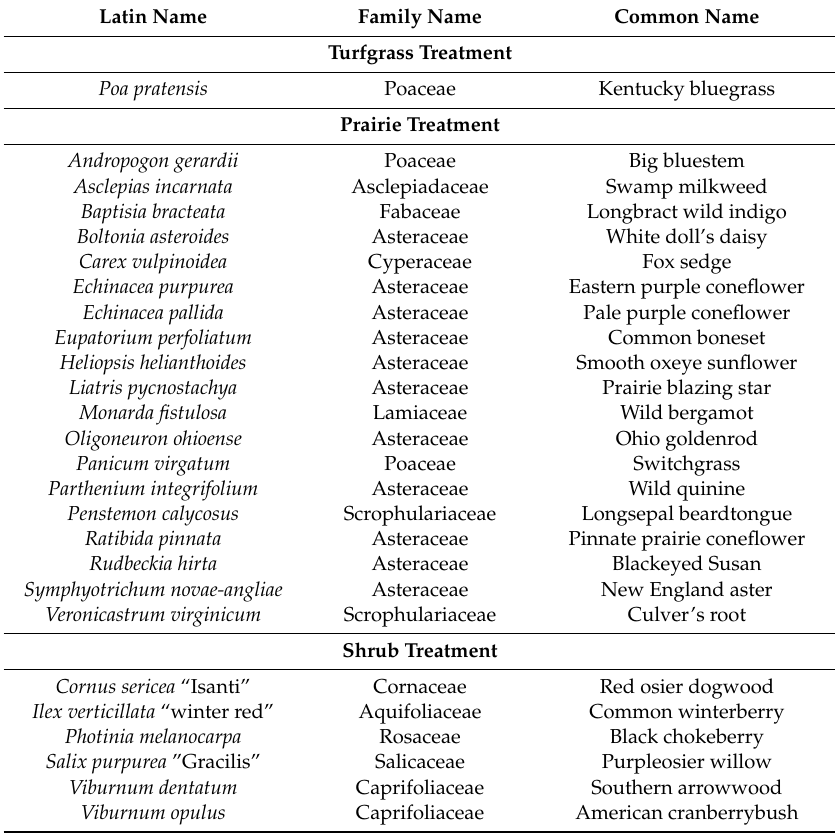
Table 1. Plant species in the turfgrass, prairie, and shrub vegetative